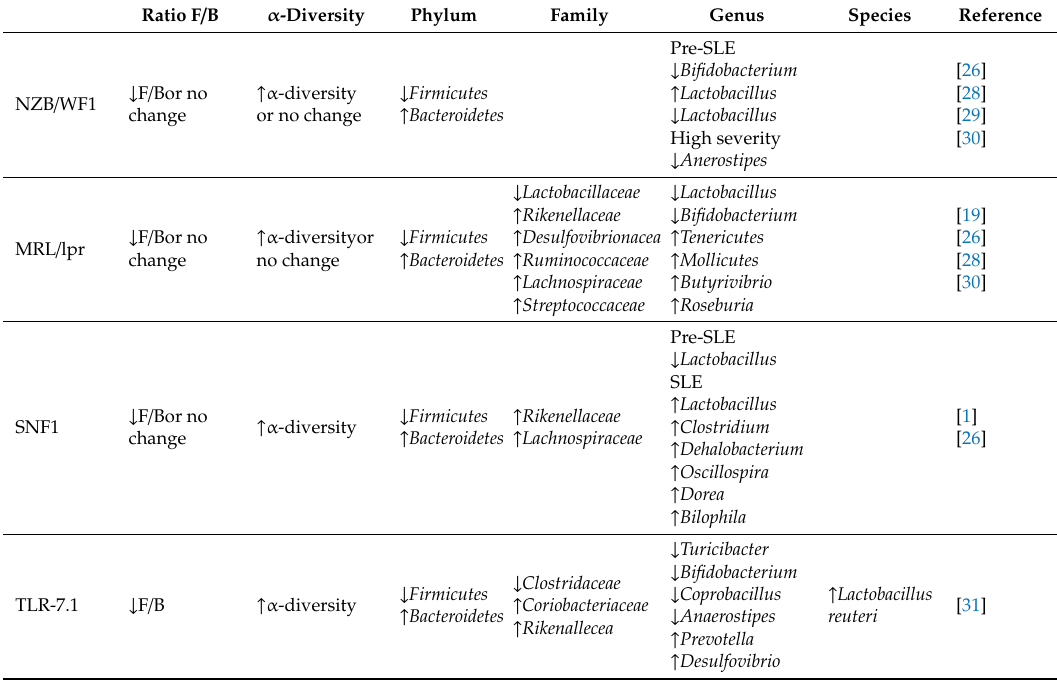
Table 2. Gut microbiota shifts in di ff erent lupus animal